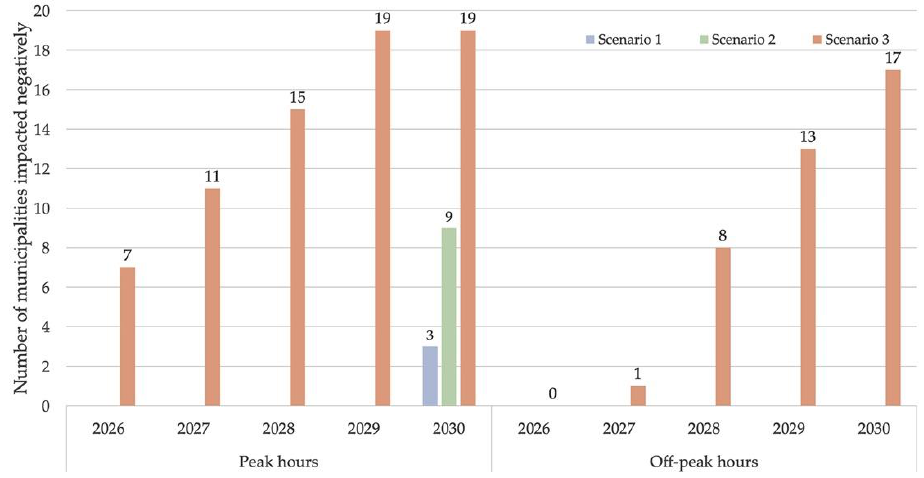
Figure 5. Number of municipalities impacted negatively during peak and off-peak hours, 2026–2030.